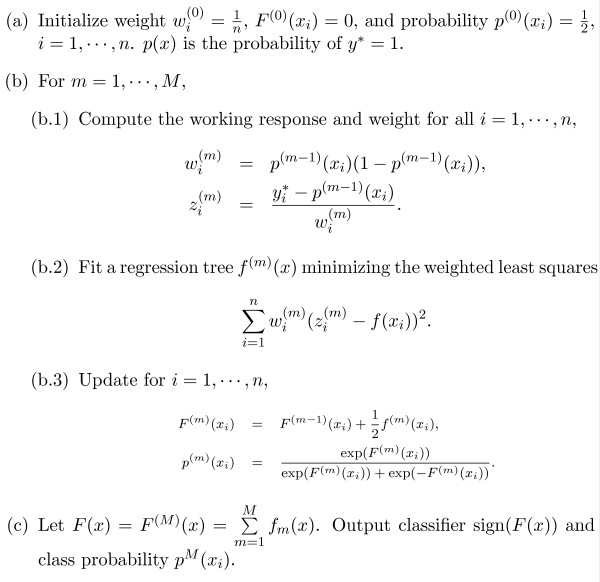
LogitBoost algorithm with trees.